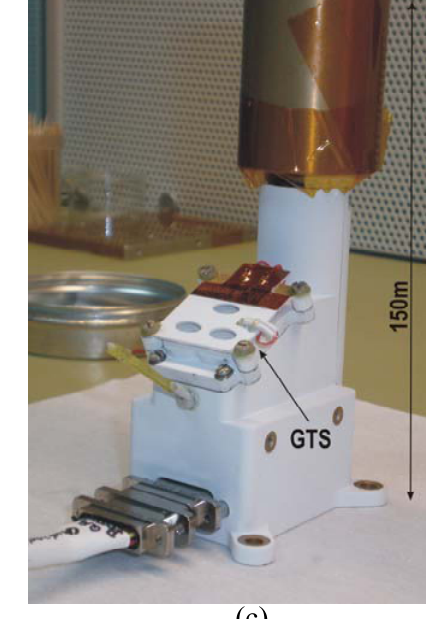
Figure 1. (a) Recreation of the NASA MSL Curiosity Rover on Mars; (b) Layout of REMS GTS focused ground area; (c) A photograph of REMS Boom 1 Flight